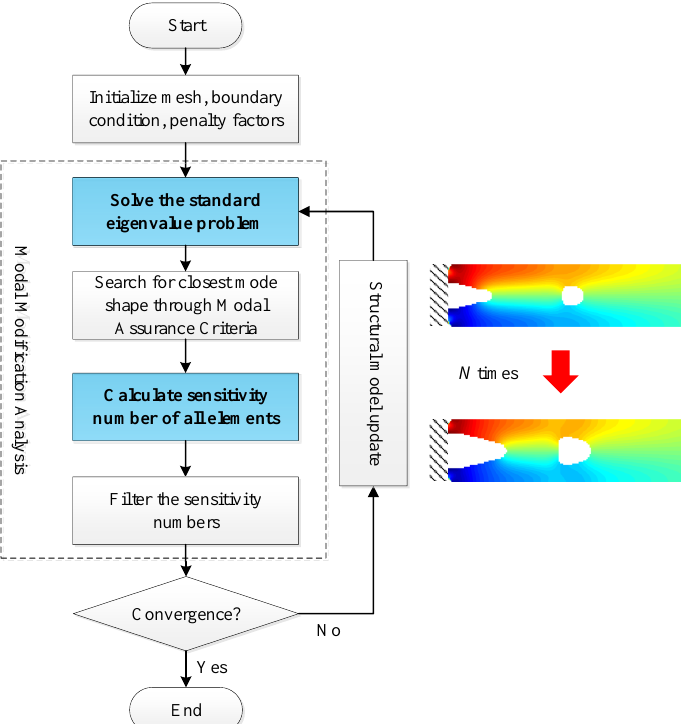
Figure 2. Flowchart of the topology optimization process. Marked in blue in Figure 2, the solution of the eigenvalue problem and calculation